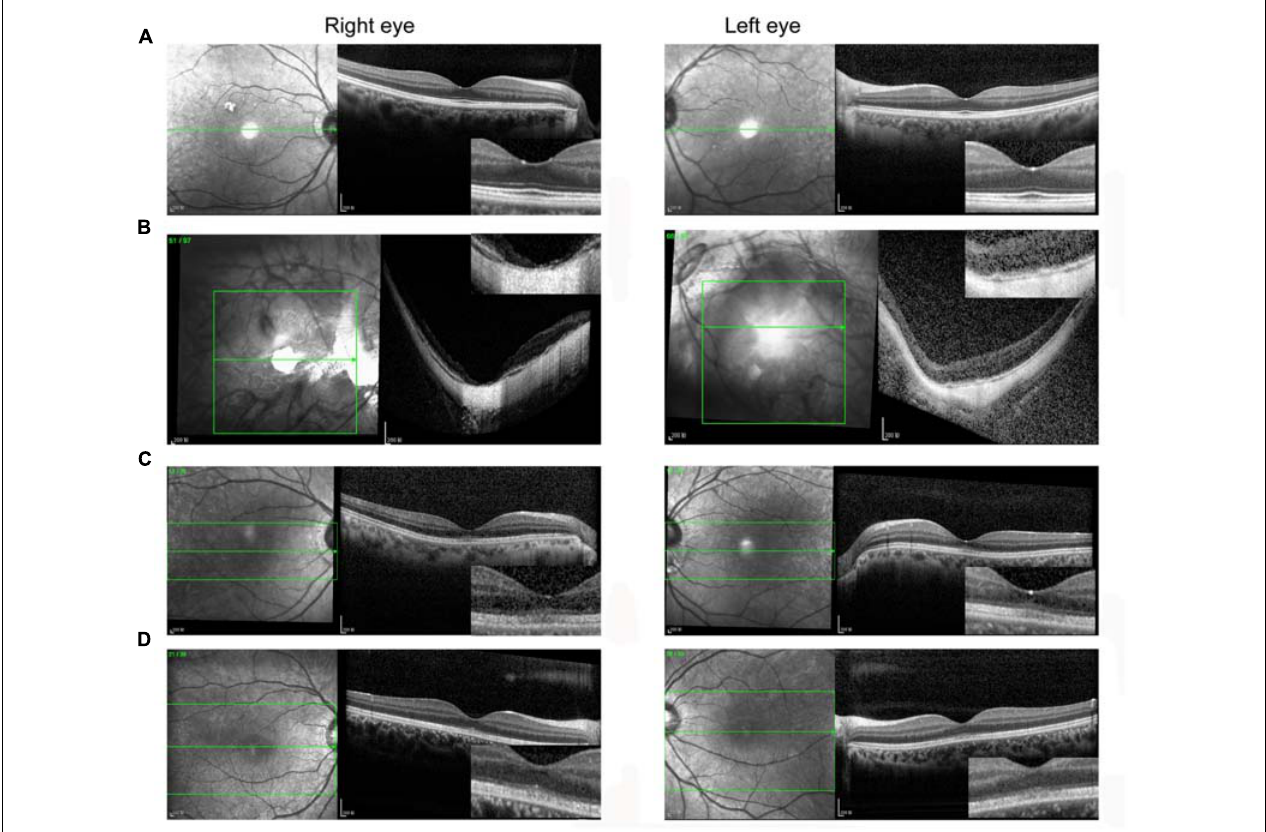
FIGURE 2 | Spectral domain optical coherence tomography images of the fovea. (A) P3; (B) P4; (C) P5; (D) P7. (A,B) The retinal thickness and structures in both the fovea and the perimacular region were normal (A) , but severely damaged in (B) . (C,D) The interdigitation and ellipsoid zones were disrupted at the fovea but were still visible in the perimacular